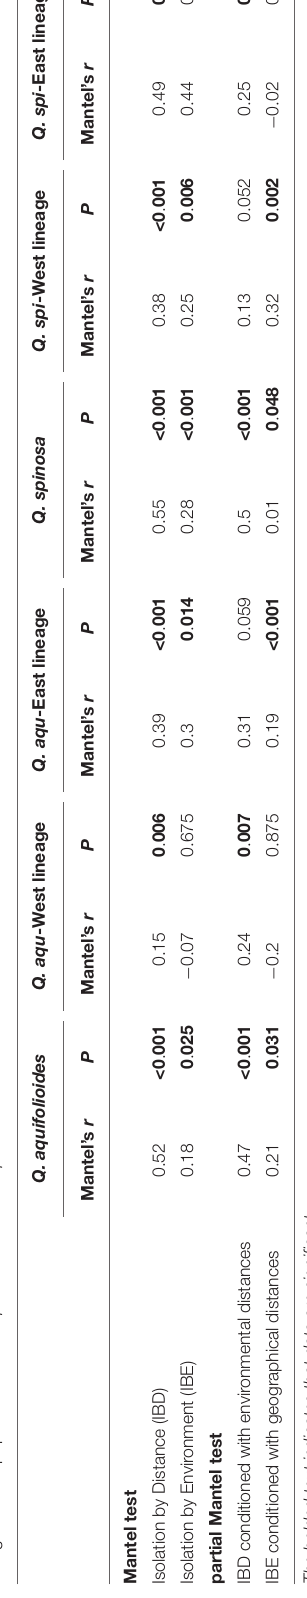
The percentages of variance explained by RDA and p RDA were similar, and we thus report results for p RDA. Geography (4.0 and 5.2%) explained more genetic variance than climate variables (1.5 and 3.0%) in Q. aqu -West and Q. spi -East lineage, whereas climate variables (2.7 and 5.6%) explained more genetic variance than geography (1.4 and 5.1%) in Q. aqu -East and Q. spi -West lineage ( Table 5 ). Partitioning of the total genetic variance revealed that bio07 and prec06 explained most